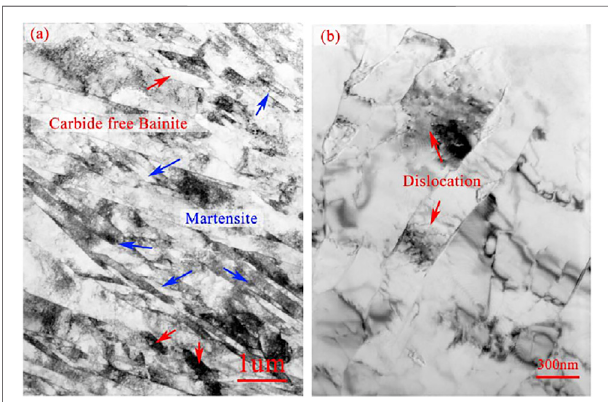
FIGURE6| TEMimagesofNSMsteelscooledat0.1 ° C/s. (A) martensite lath (blue indications) and bainite lath (red indications), (B) dislocations in carbide free bainite lath.